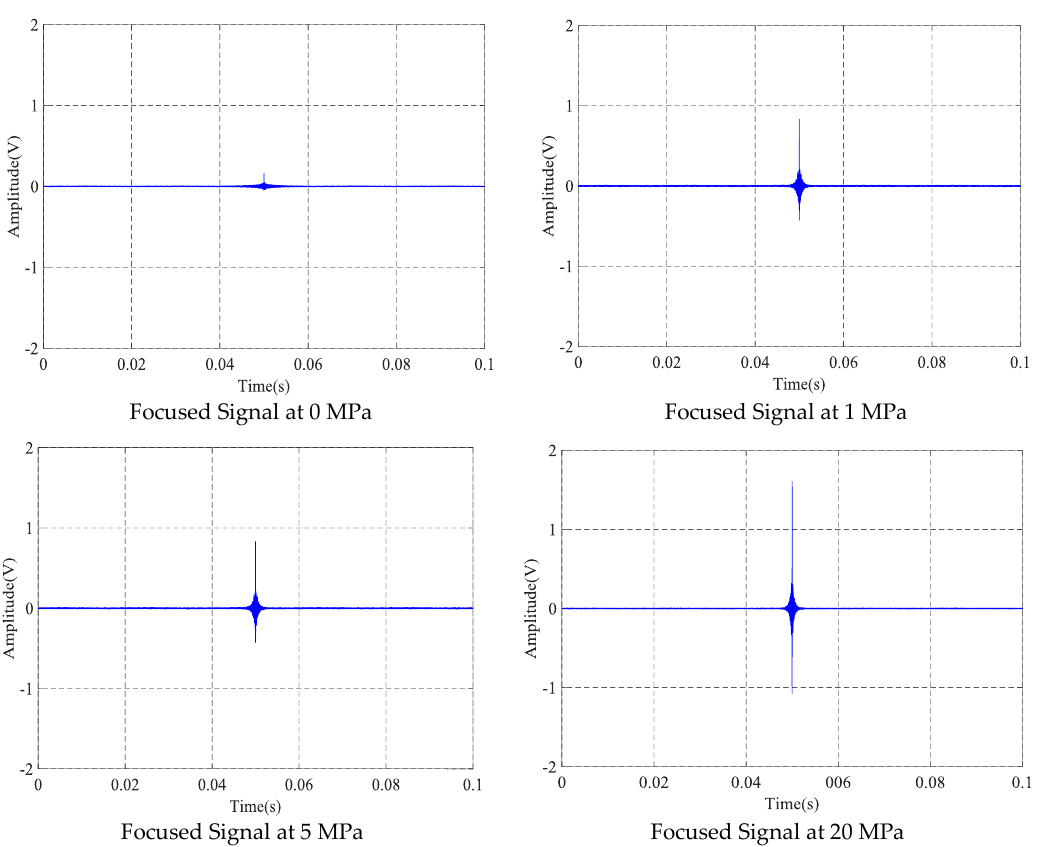
Figure 12. Focused signals based on the time reversal method at different tension levels.